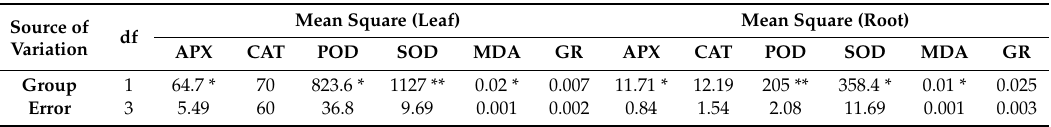
Table 2. Unbalanced completely randomized design between tolerant (UCB-1, Badami, and Ghazvini) and susceptible (Akbari and Kale-Ghouchi) rootstocks.